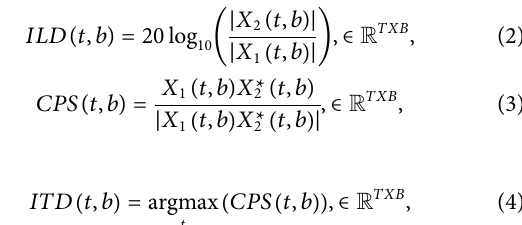
Frontiers in Signal Processing |